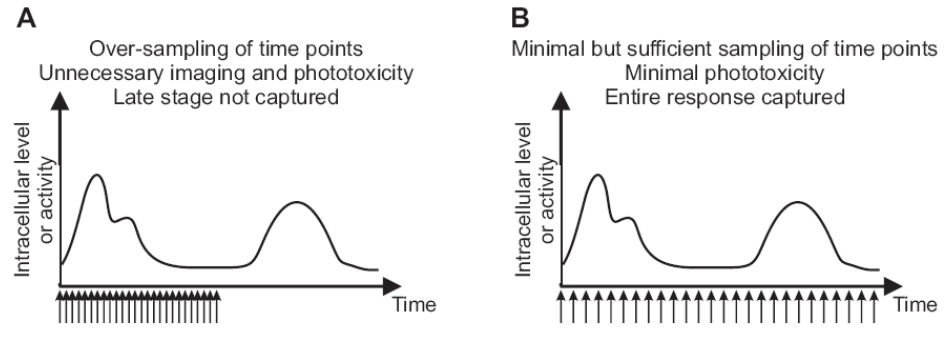
Figure 3. The frequency of imaging and duration of time lapse capture influence cell viability and coverage of relevant dynamic patterns. ( A ) Too frequent acquisition of time points for which the images are acquired without adding information about the dynamic pattern. Frequent illumination causes toxicity or cell stress that alters the physiological behavior of cells during monitoring. The duration of imaging is not long enough to capture late-stage activity. ( B ) The same number of time points as in ( A ) are distributed over a longer time course. The temporal resolution is still sufficient to capture fluctuations, while producing little or no photo-toxicity. The duration of monitoring is long enough to cover the complete